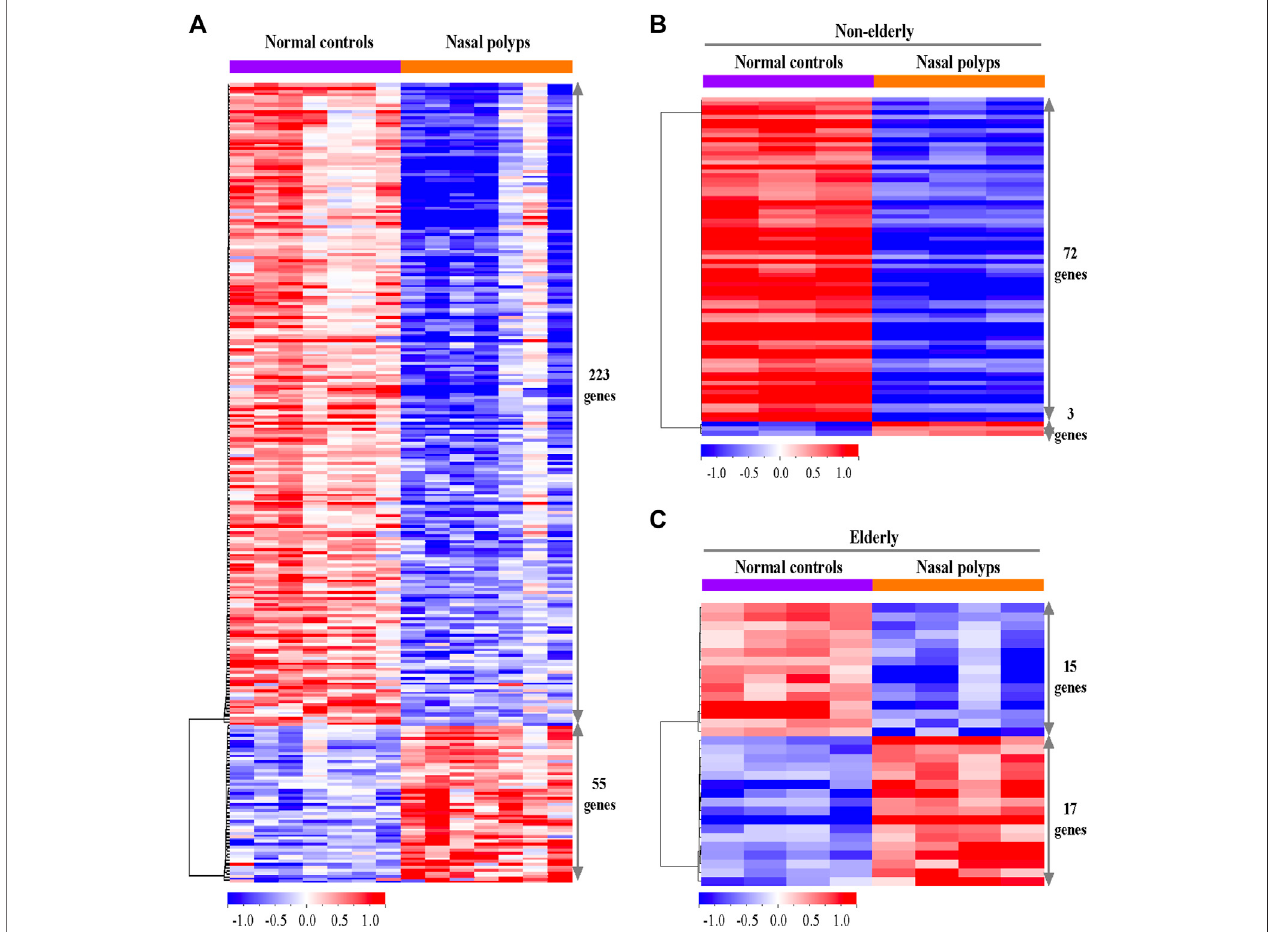
FIGURE 1 | Differentially expressed genes in the sinonasal tissues from subjects with NP and normal controls. (A) The heatmaps represent expression pro fi les of the 278 differentially expressed genes in normal controls versus NP, (B) the 75 differentially expressed genes in non-elderly normal controls versus non-elderly and (C) the 32 differentially expressed genesin elderly normal controls versus elderly NP. A red-blue color scale depicts expression levels (upregulated; red and downregulated; blue).